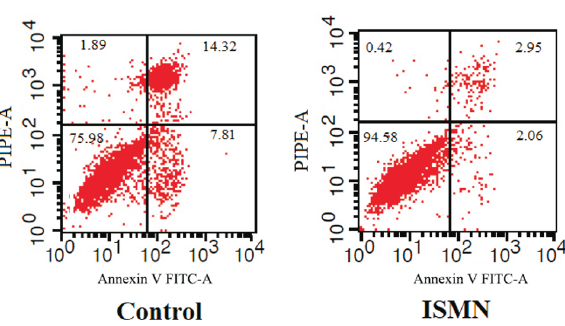
Figure 6 - Effects of ISMN on HUVEC apoptosis by Annexin V-FITC/PI flow cytometry. Q1 (annexin V-/PI+) - cells with features of necrosis; Q2 (annexinV+/PI+)-cellswithfeaturesoflateapoptosis;Q3(annexinV-/PI-) - viable cells; Q4 (annexin V+/PI-) - cells with features of early